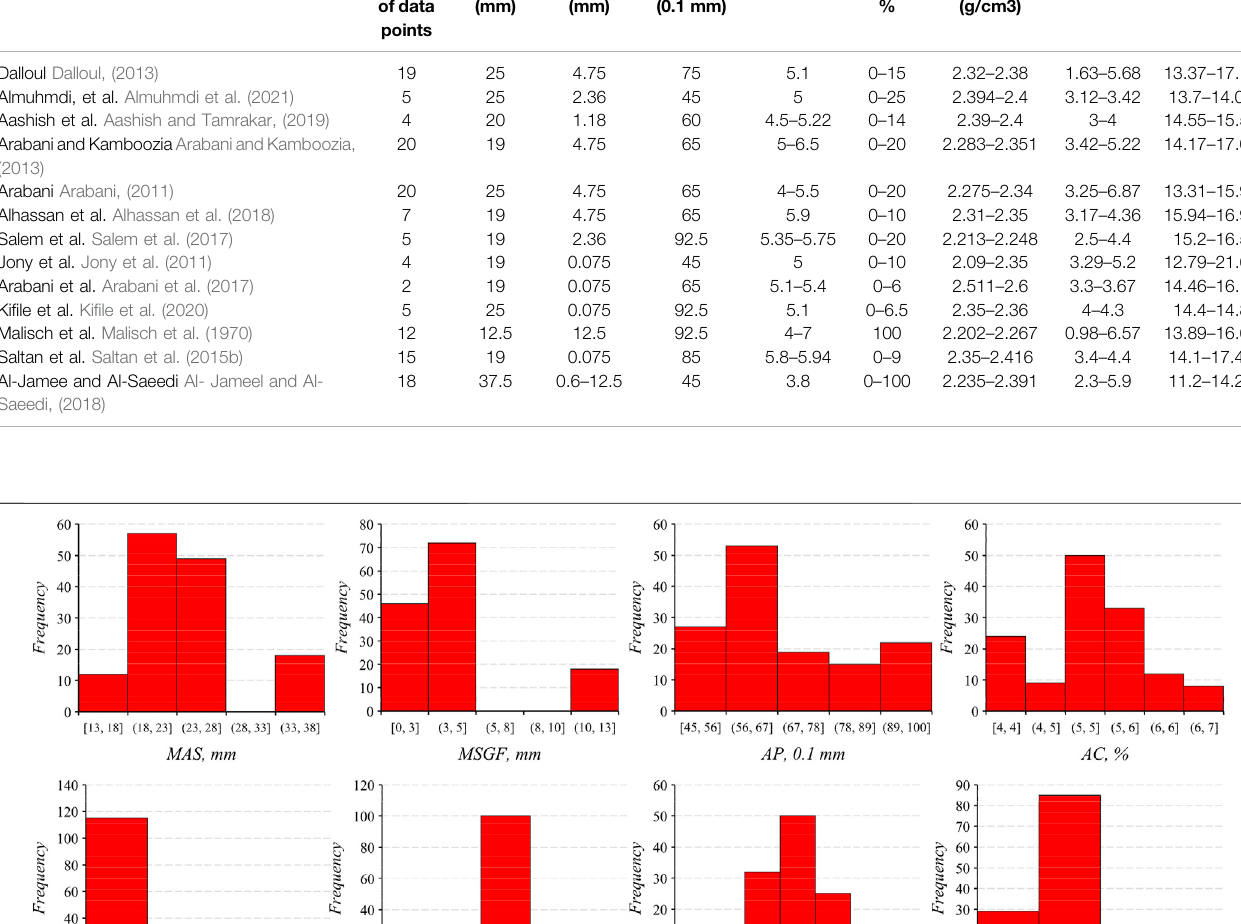
TABLE 1 | Collected database used in the ANN models. Reference